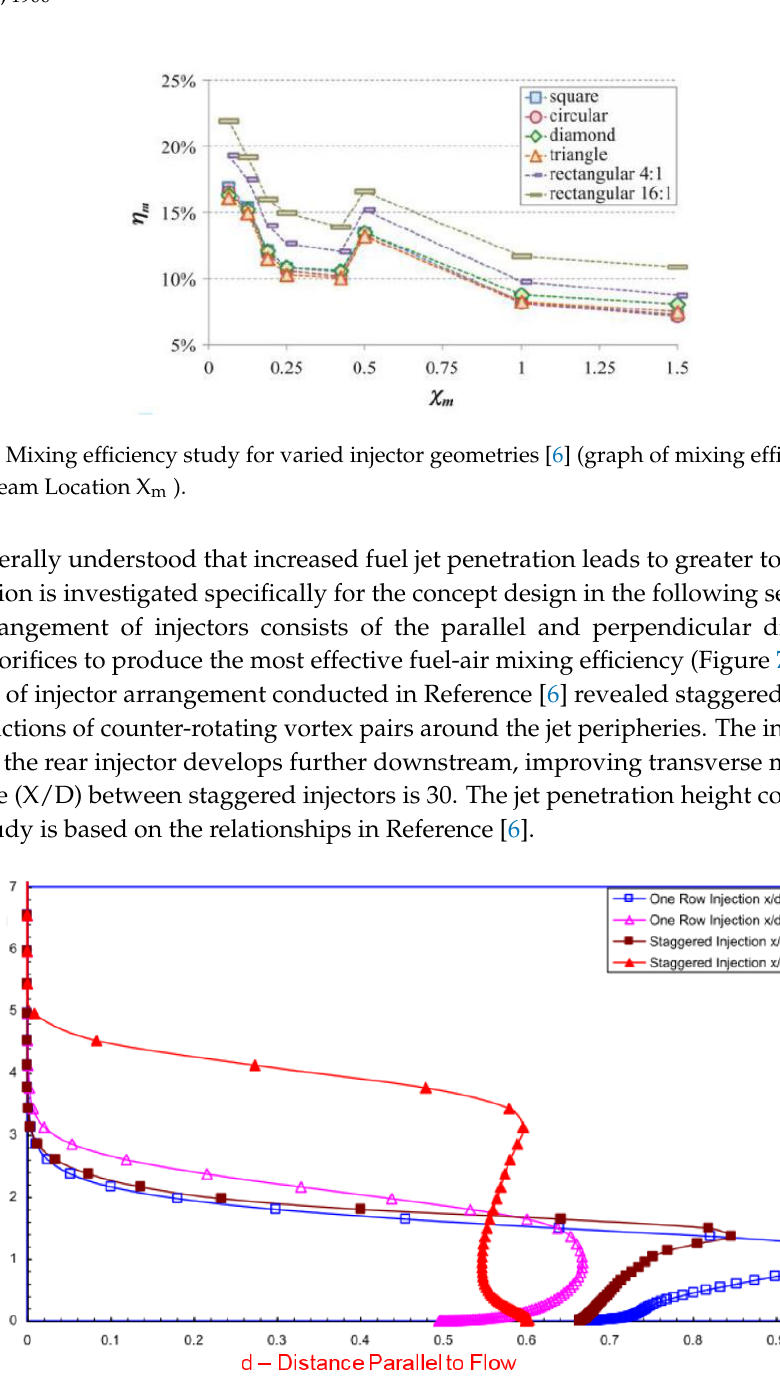
Figure 7. H 2 jet penetration (Y/D) of staggered and aligned injector arrangements [6].